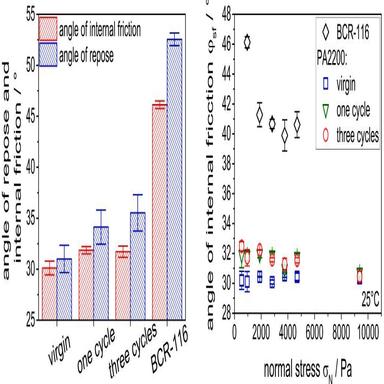
(Left) Angle of repose at ambient conditions and angle of internal friction at 25 ◦C and 960 Pa normal stress for differently aged polyamide 12 powders and BCR-116 limestone reference material. (Right) Angle of internal friction at 25 ◦C and varying normal stress for differently aged polyamide 12 powders and BCR-116 limestone reference material. Error bars indicate the standard deviation over ten measurements for the AOR and five measurements for the angle of internal friction, respectively.